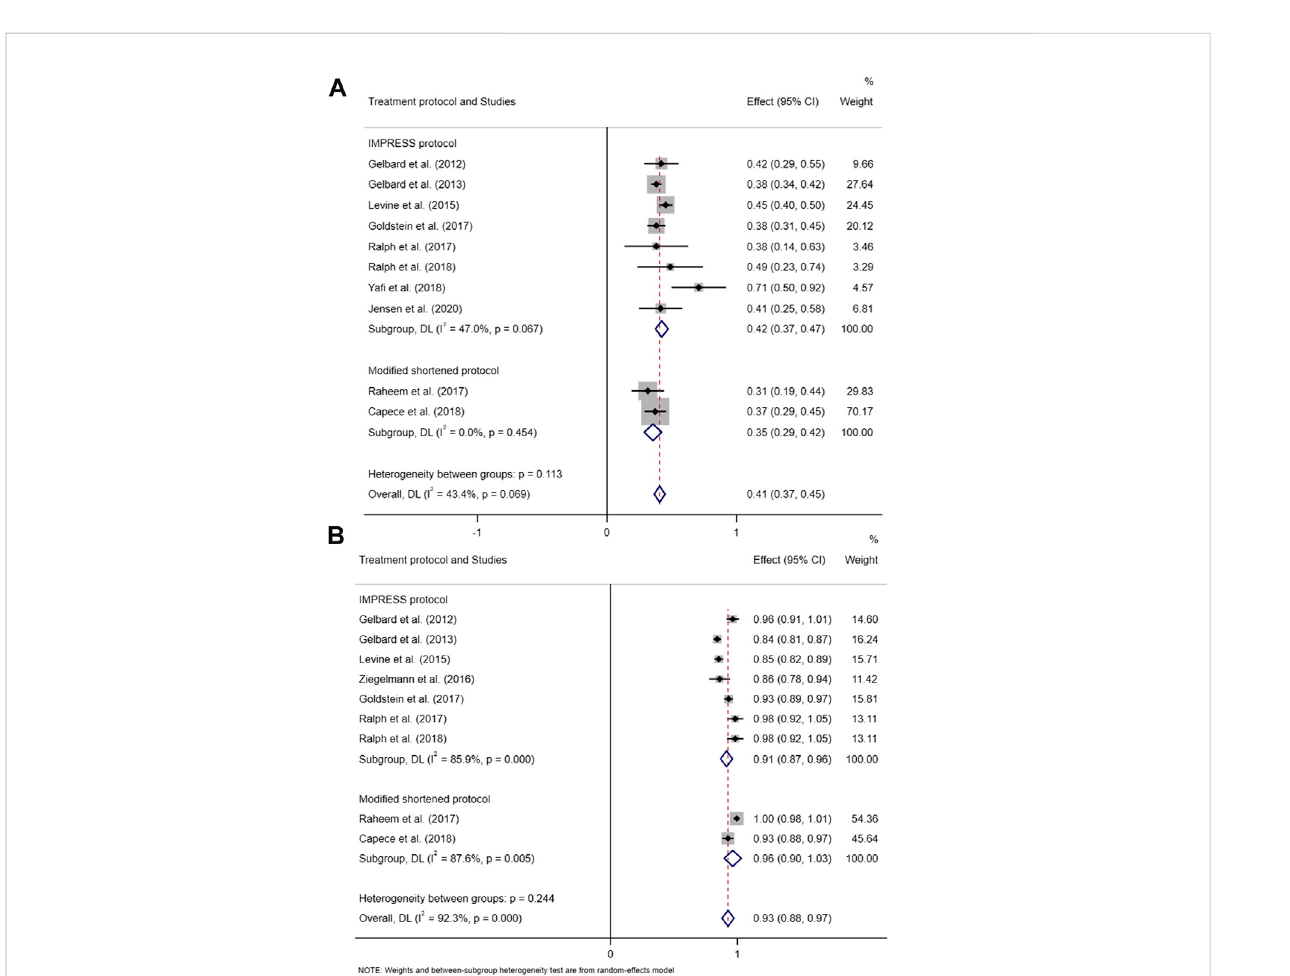
FIGURE 3 Forest plotofthepooledpercentageofimprovedPDbother score basedonsubgroupanalysis (strati fi edbythetreatmentprotocol) (A) andthe forest plot of the pooled TRAEs based on subgroup analysis (strati fi ed by the treatment protocol) (B) .